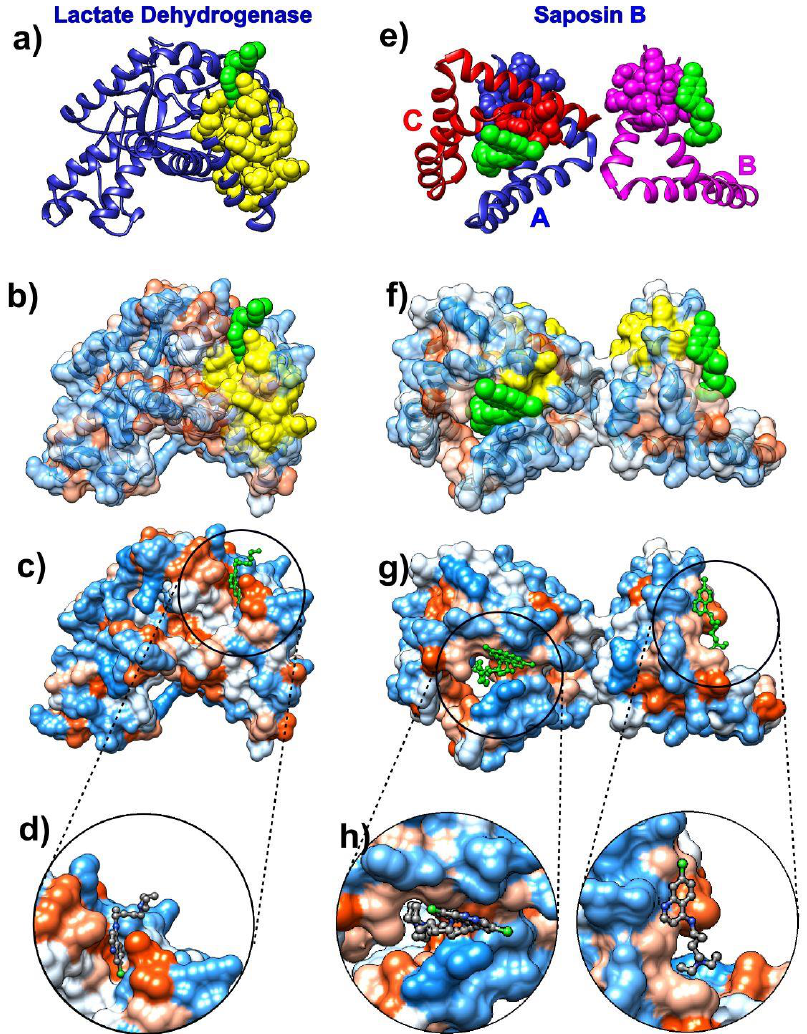
Figure 1. Chloroquine and its target proteins. Images on the left depict chloroquine bound to the cofactor binding site of Plasmodium falciparum lactate dehydrogenase (pdb id 1cet). Images on the right depict chloroquine bound to saposin B (pdb id 4v2o). ( a ) Lactate dehydrogenase is depicted as a blue ribbon, self-adjustable Gaussian network model (SAGNM) predictions are yellow and chloroquine green atoms. ( b ) Lactate dehydrogenase is depicted as a transparent hydrophobic surface (chain is visible as ribbon inside surface). SAGNM predictions are depicted as yellow atoms and chloroquine as green atoms. ( c ) Lactate dehydrogenase is depicted as an opaque hydrophobic surface and chloroquine as green balls and sticks. ( d ) The inset shows chloroquine within the hydrophobic pocket. ( e ) Saposin B chains are depicted as blue (chain A), pink (chain B), and red (chain C) ribbons. SAGNM predictions are depicted as blue, pink, and red atoms. Chloroquine molecules are shown as green atoms. ( f ) Saposin B is depicted as a transparent hydrophobic surface. SAGNM predictions are depicted as yellow atoms and chloroquine green atoms. ( g ) Saposin B is depicted as an opaque hydrophobic surface and chloroquine as green balls and sticks. ( h ) The two insets show chloroquine molecules within the hydrophobic pockets on the surface of the saposin B trimer. The figure is produced with the UCSF Chimera program [44].